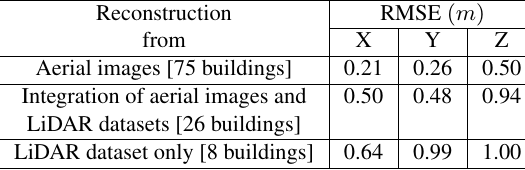
Table 5: RMSE calculated on gravity centers of homologous planes.